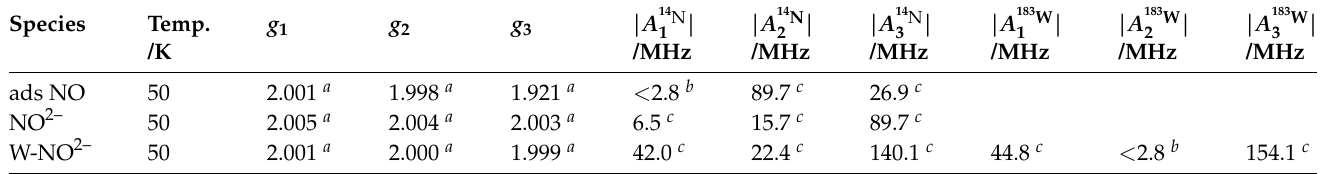
Table 1. Spin Hamiltonian parameters of the NO centres associated with N